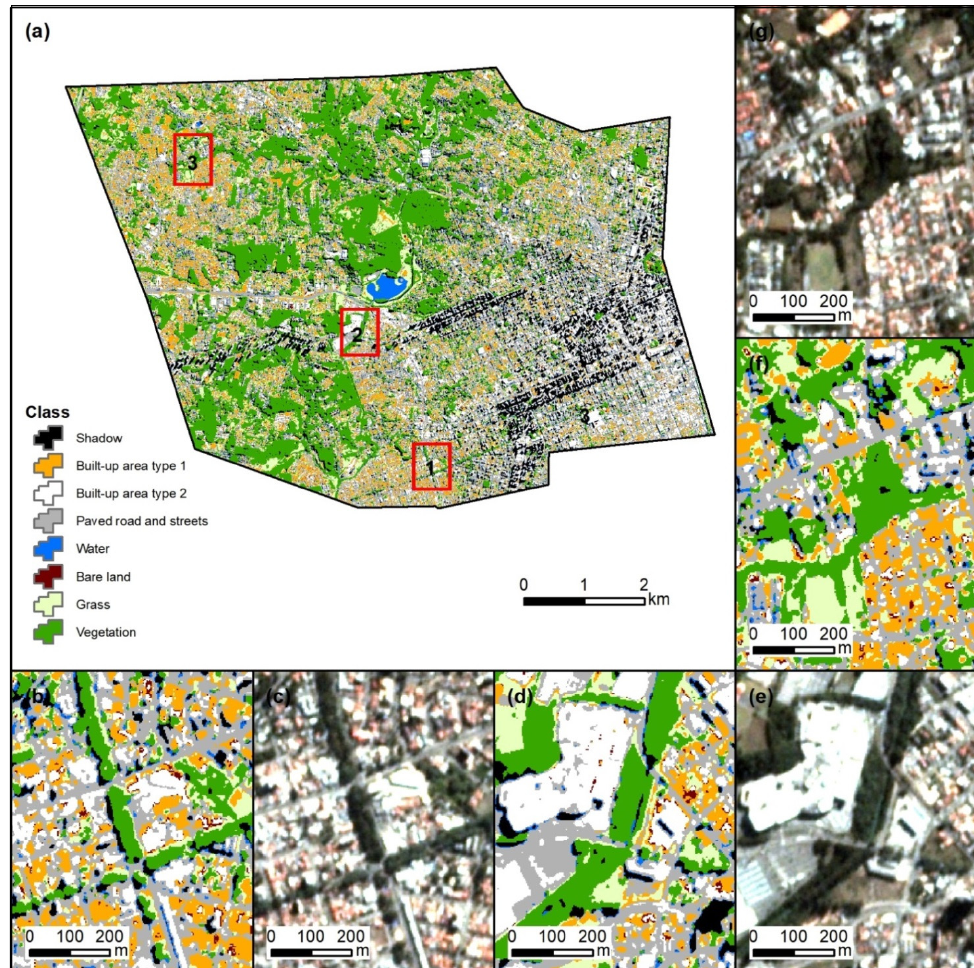
Table 7. Summary of validation metrics for the classifications with best performance.